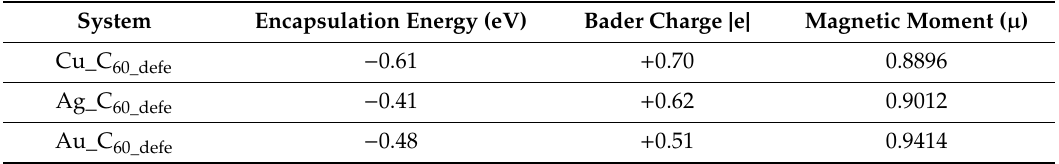
Figure 9. Relaxed structures and charge density plots of Cu ( a ), Ag ( b ) and Au ( c ) adsorbed on the surface of defective C 60 molecule. Table 6. Encapsulation energies, Bader charge on the metal atoms and magnetic moments of the composites formed between the surface of defective C 60 molecule and